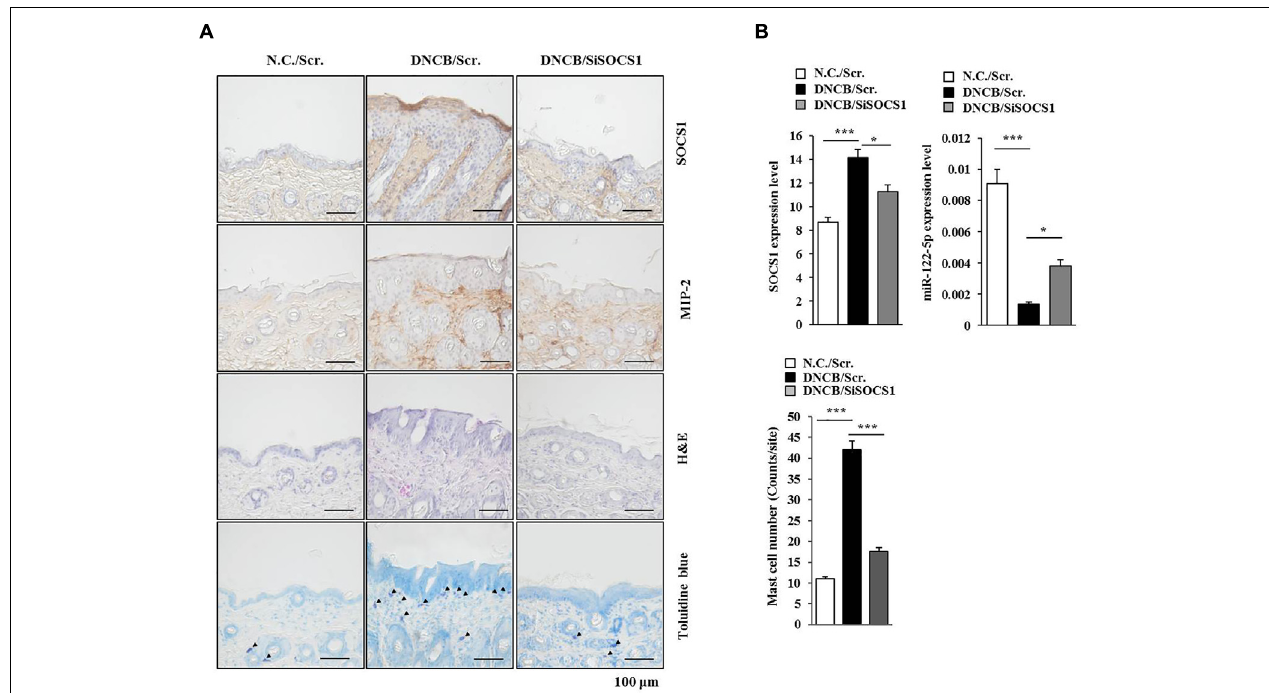
FIGURE 7 | SOCS1 regulates the expression of miR-122a-5p and MIP-2. (A) Immunohistochemical staining by employing the indicated antibody was performed. Scale bar represents 10 µ m. Skin tissues of BALB/c mice of each experimental group were isolated at the time of sacrifice and were also subjected to H&E staining. Toluidine blue staining was performed to determine the number of degranulated mast cells. Closed triangle represents degranulated mast cells. (B) Tissue lysates from mouse of each experimental group were subjected to qRT-PCR analysis. ∗ p < 0.05; ∗∗∗ p < 0.0005. The number of degranulated mast cells was also determined. Closed triangle represents degranulated mast cells. Scale bars represent 100 µ